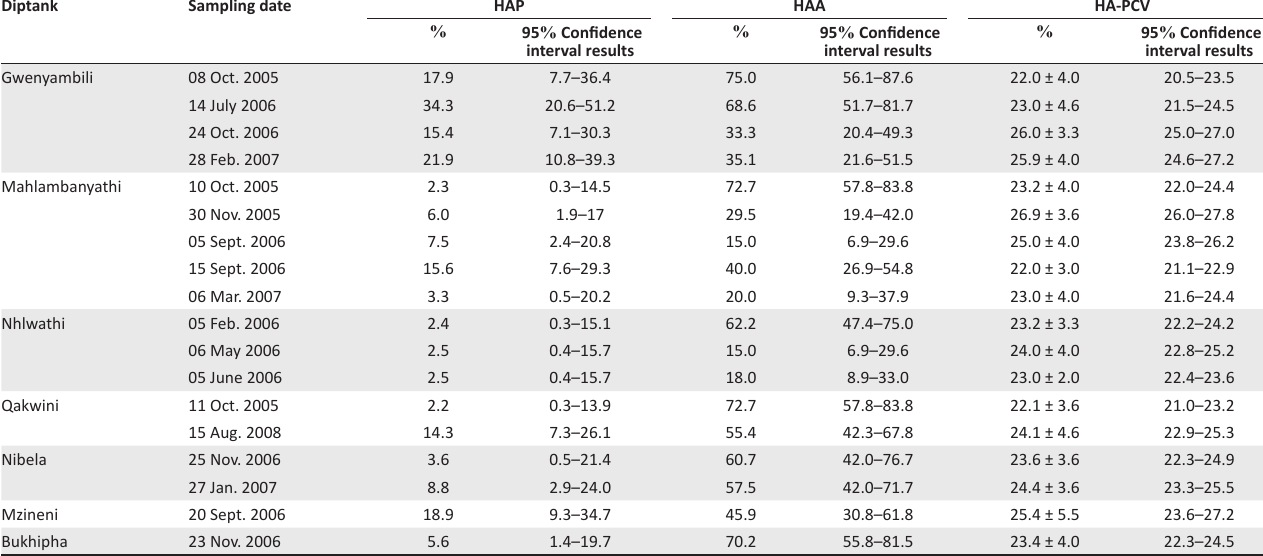
TABLE 1: Trypanosome survey at the seven communal diptanks showing means ± standard deviation and 95 % confidence interval results of the herd average prevalence, herd average anaemia and herd average packed cell volume.